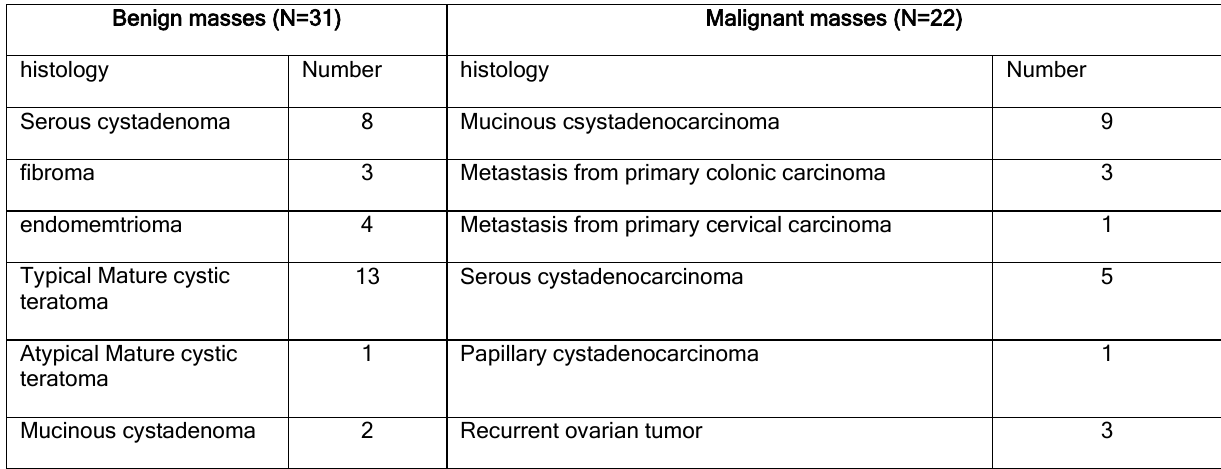
Table 1: Histology of ovarian masses. Benign masses (N=31)